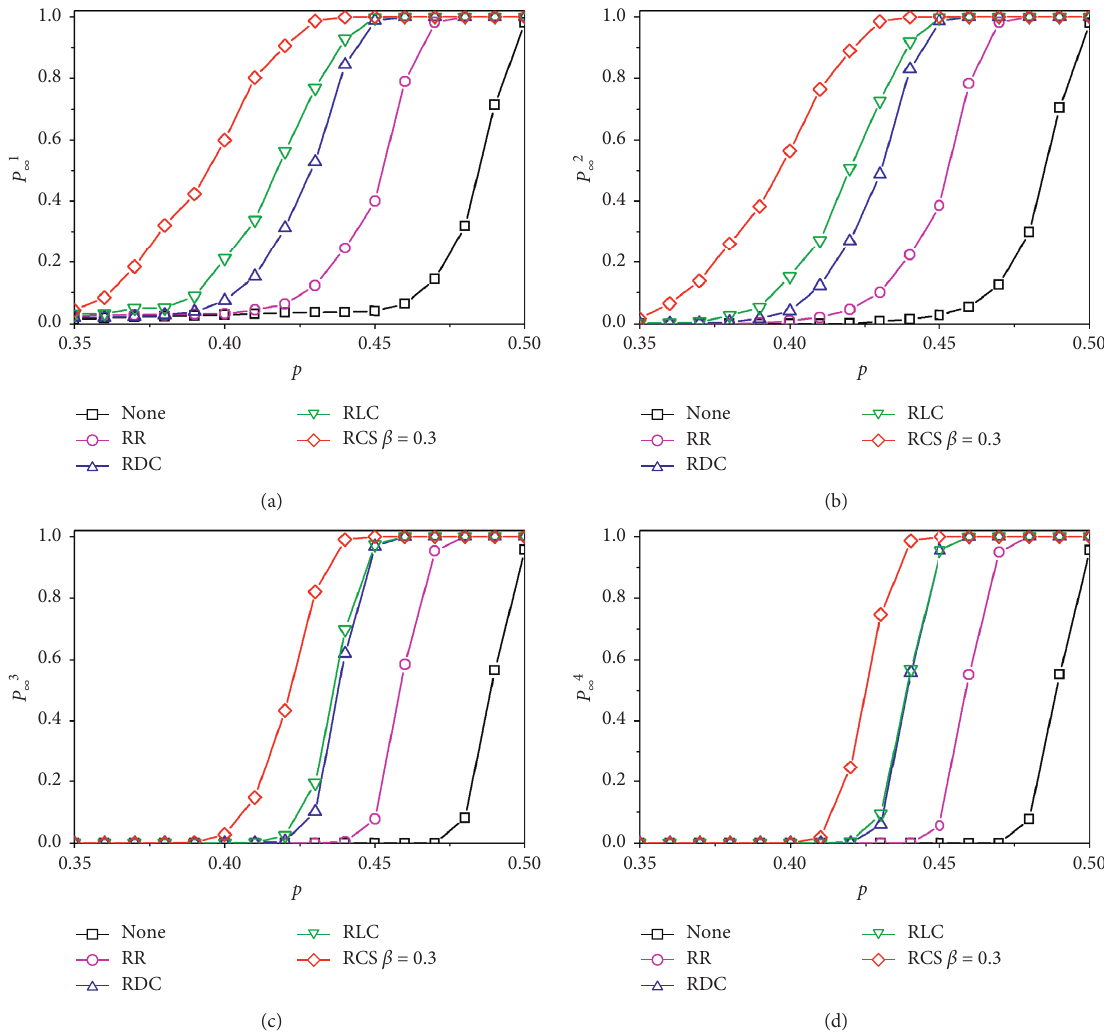
Figure 7: The existence probability of giant component as a function of the fraction of surviving nodes p . (a) P 1